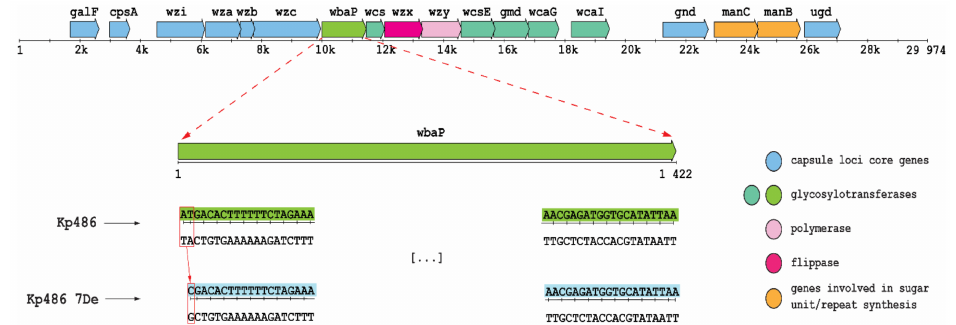
Figure 2. Genetic organization of K63 cps region in Kp486 strain and a frameshift mutation in Kp7De mutant. Arrows indicate the direction and relative length of open reading frames (ORFs). Base deletion and substitution (box) were observed in the start codon of wbaP gene in Kp7De.